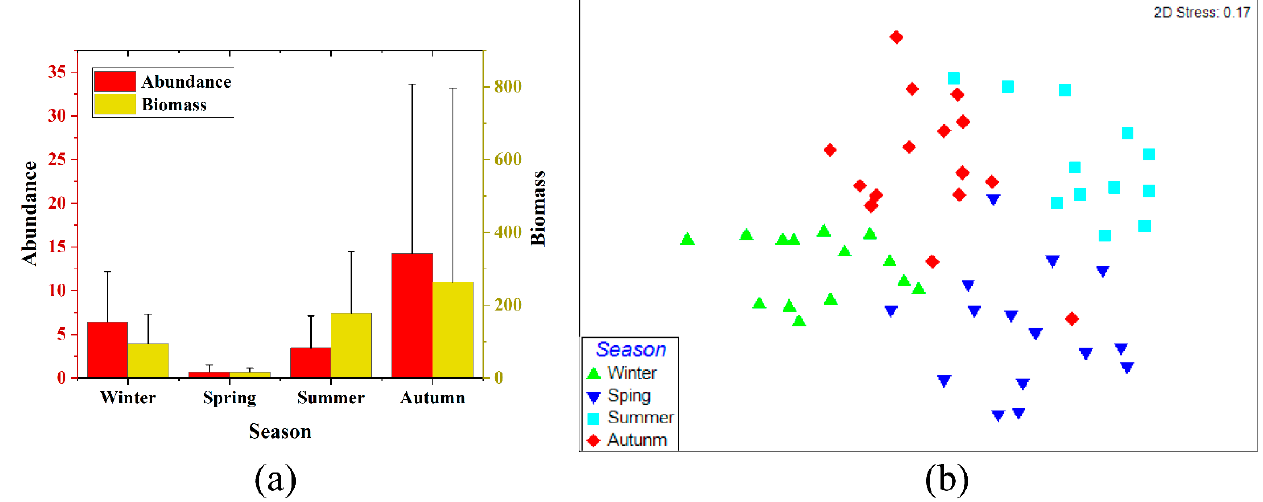
Figure 2. Seasonal variations in fish mean abundance and mean biomass ( a ), where error bars indicate standard deviations, and NMDS plot of assemblage structure ( b ) for 2018.